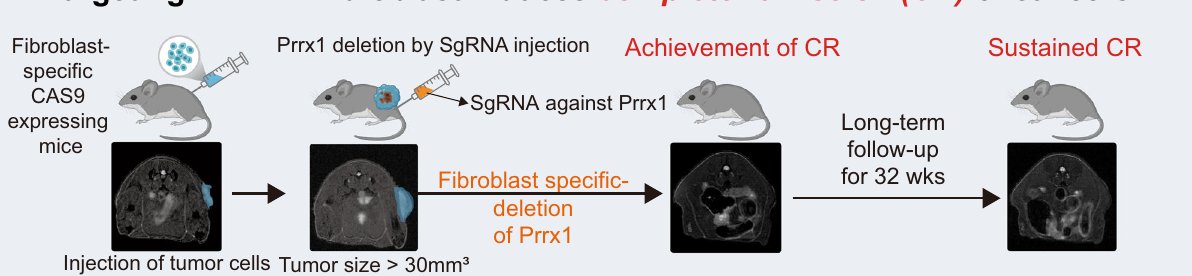
Fidelity DNA Polymerase (NEB). Oligos are listed in the Supplementary Information. To evaluate indels caused by cleavage of one gRNA, puri fi ed PCR products were Sanger sequenced and analyzed using the SYNTHEGO ICE software.